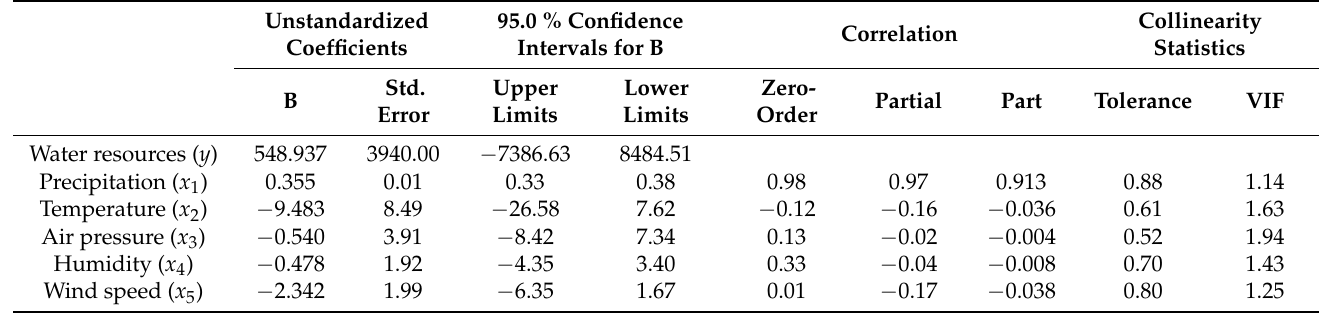
Table 6. Multiple regression calculation results of water resources and climate